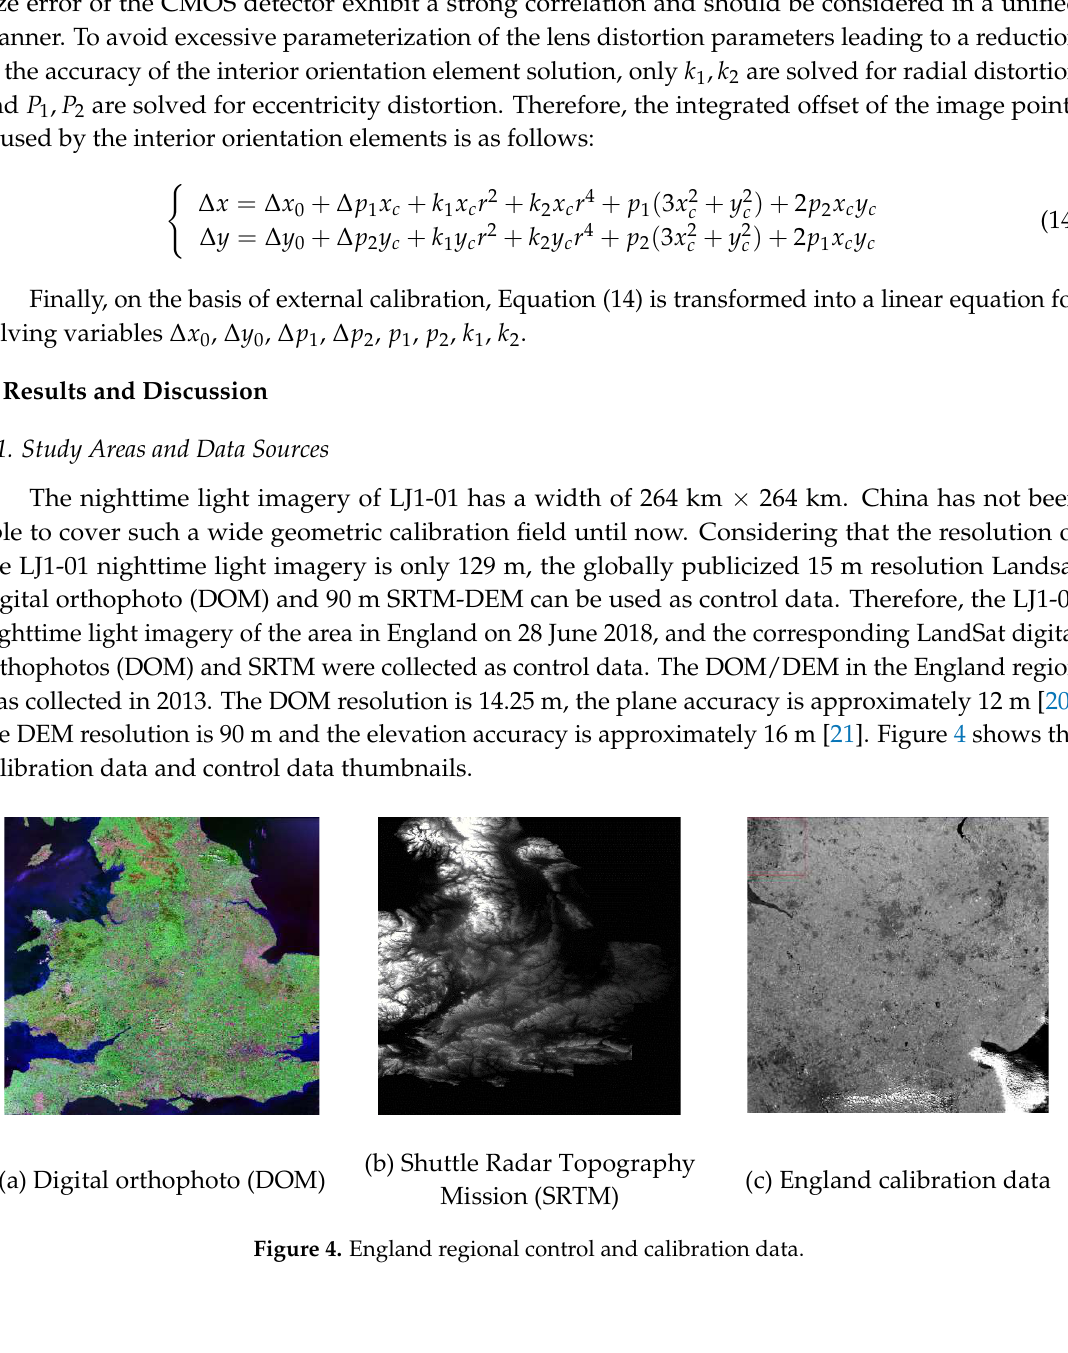
(c) Mexico verification data Figure 5. Mexico Torreon regional control and verification data. (a) DOM